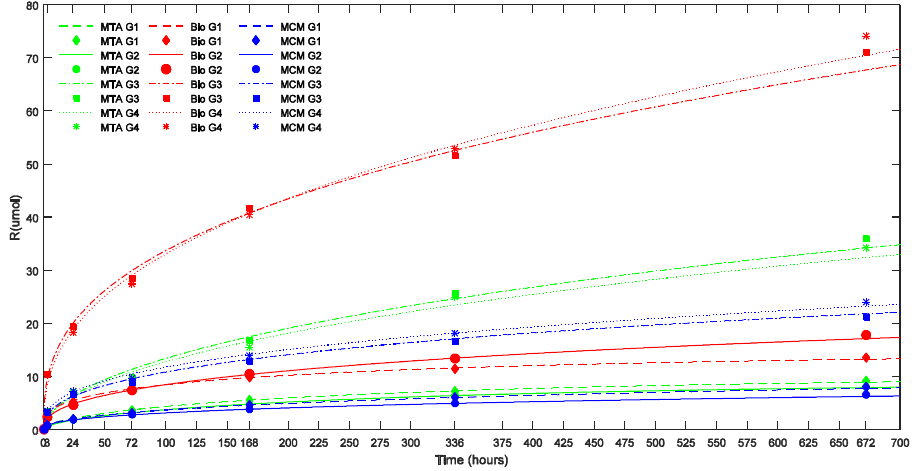
Figure 3. Effect of sample dimensions (Vol and ESA) on cumulative calcium ion release (R) of the TSCs studied (in μmoles) as a function of time. The points represent the measured values and the lines show the calculated values according to Equation (1). Bio: Biodentine™; MCM: Medcem MTA ® ; MTA: ProRoot ® white MTA. G1: Group 1 (1.5 × 5 mm; Vol: 8.835 mm 3 ; ESA: 1.77 mm 2 ); G2: Group 2 (1.5 × 10 mm; Vol: 17.67 mm 3 ; ESA: 1.77 mm 2 ); G3: Group 3 (3.5 × 5 mm; Vol: 48.11 mm 3 ; ESA: 17.62 mm 2 ); G4: Group 4 (3.5 × 10 mm; Vol: 96.22 mm 3 ; ESA: 17.62 mm 2 ).